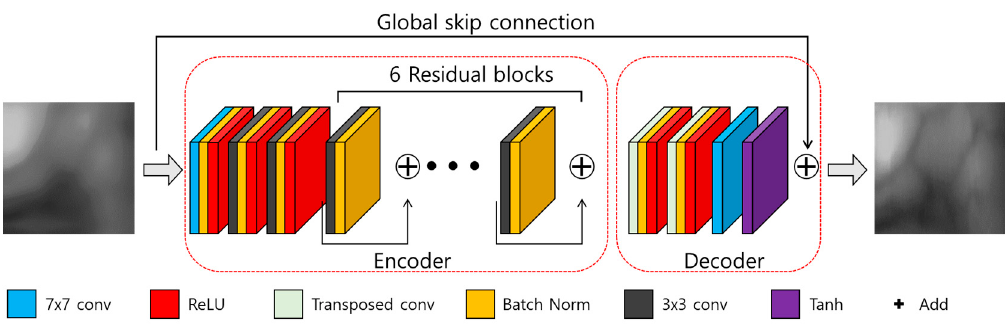
Figure 4. Generator of the modified DeblurGAN. Table 2. Descriptions of generator in modified